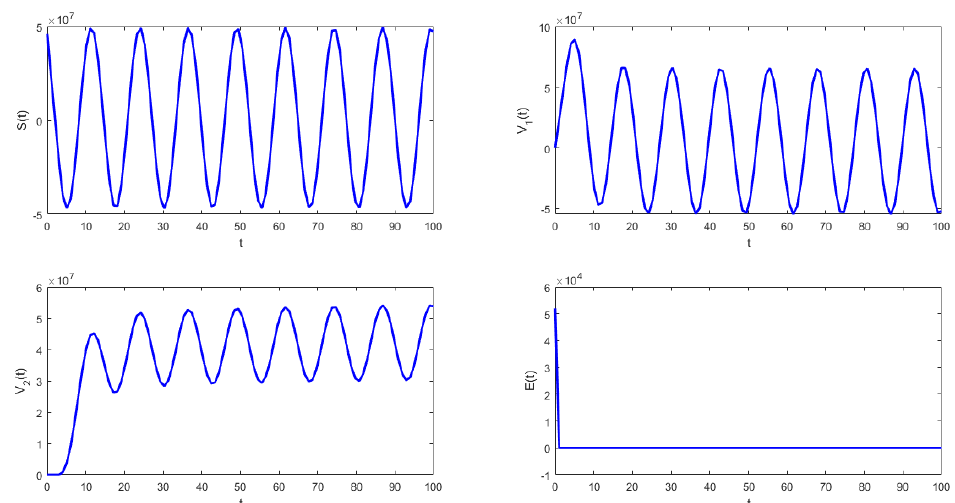
Figure 5. Numerical simulation of system (1) with the following values for the parameters: